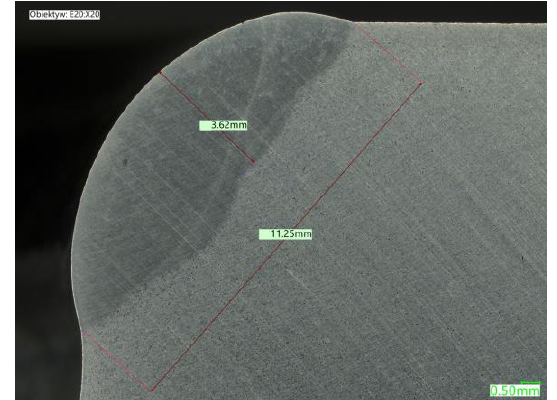
Fig. 9. cross-section of the rim of the melted combustion chamber